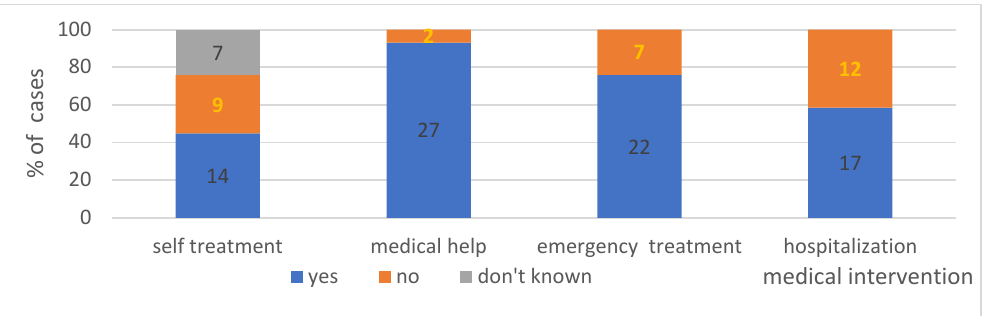
Figure 8. The medical intervention during the episode of anaphylaxis in analysed group. Absolute values of numbers of patients are given in the diagram.